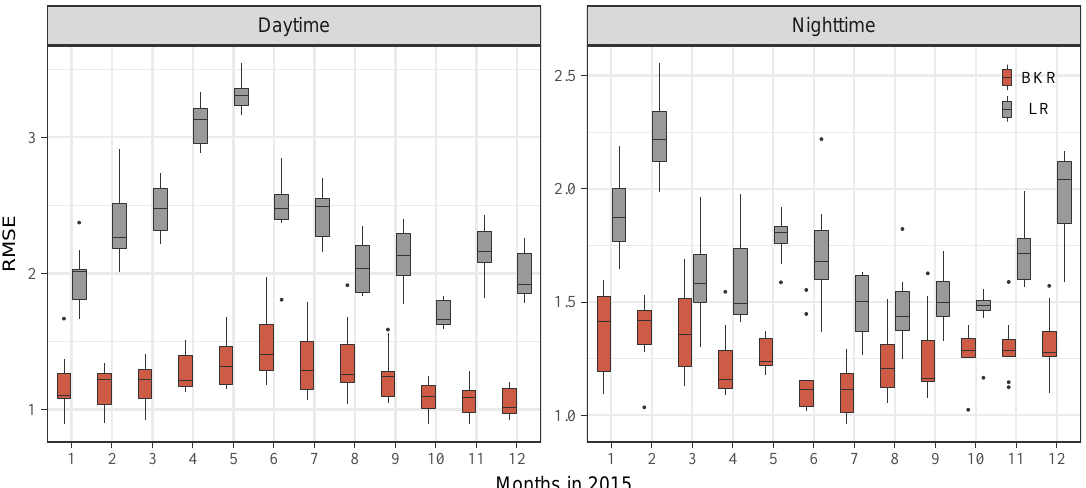
Figure 6. The whole region scenario: boxplot of root mean squared error (RMSE) of the LR and BKR for 12 months in 2015: ( left ) models in the daytime case (Tmax). ( right ) Models in the nighttime case